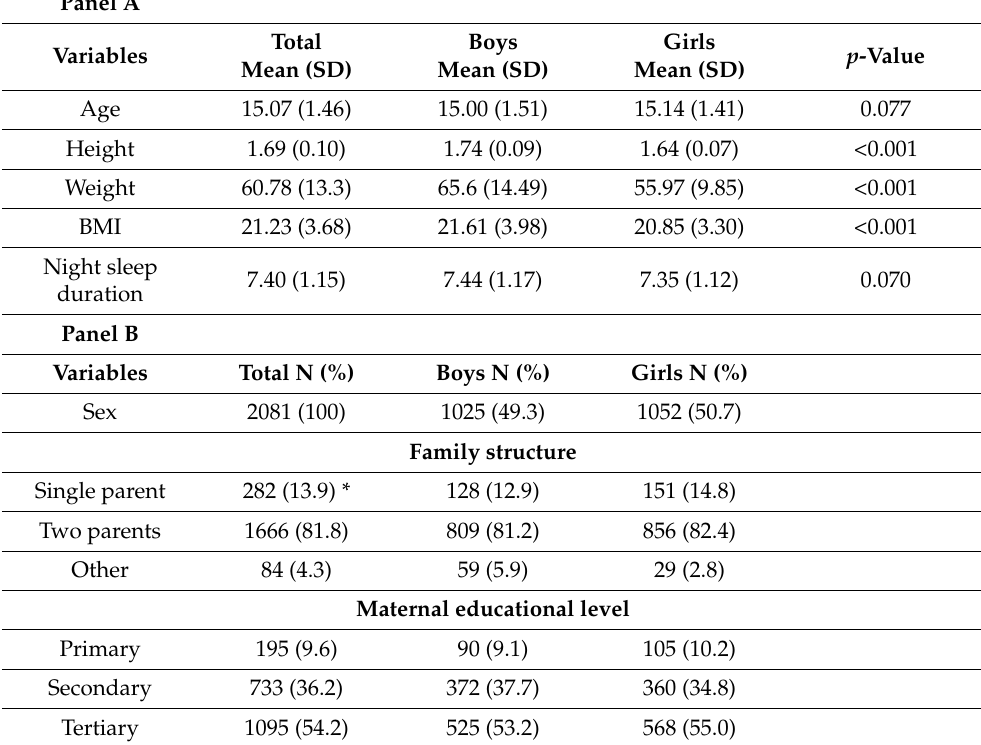
Table 1. Anthropometric and socioeconomic characteristics and the AMD by